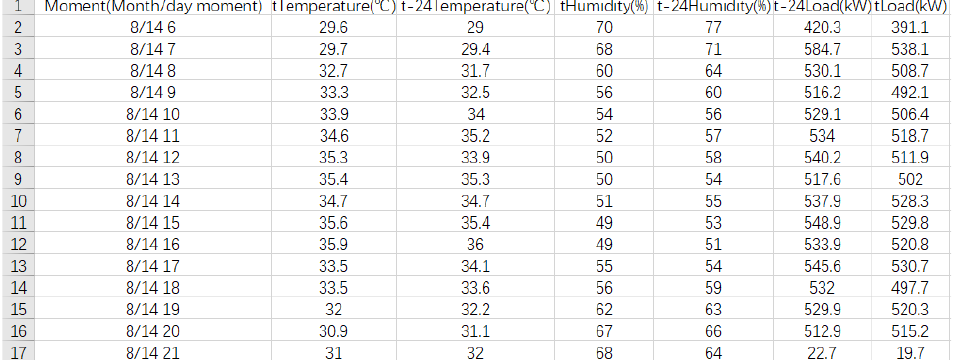
Figure 9. Hourly collected data on 14 August 2020.